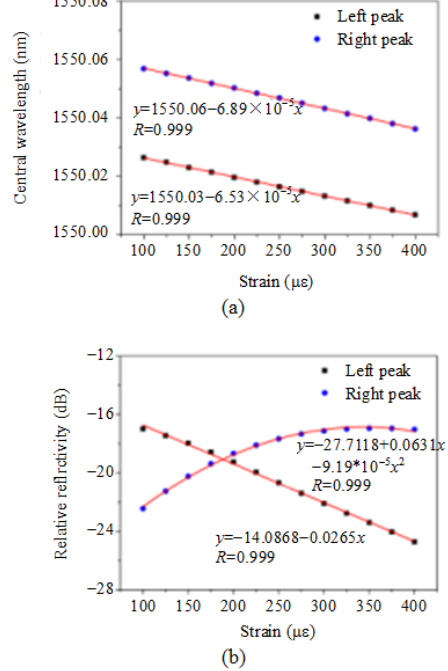
Fig. 10 Change of the reflection peaks with different strains: (a) corresponding curve of the central wavelength of two peaks to strain and (b) corresponding curve of the relative reflectivity of two peaks to